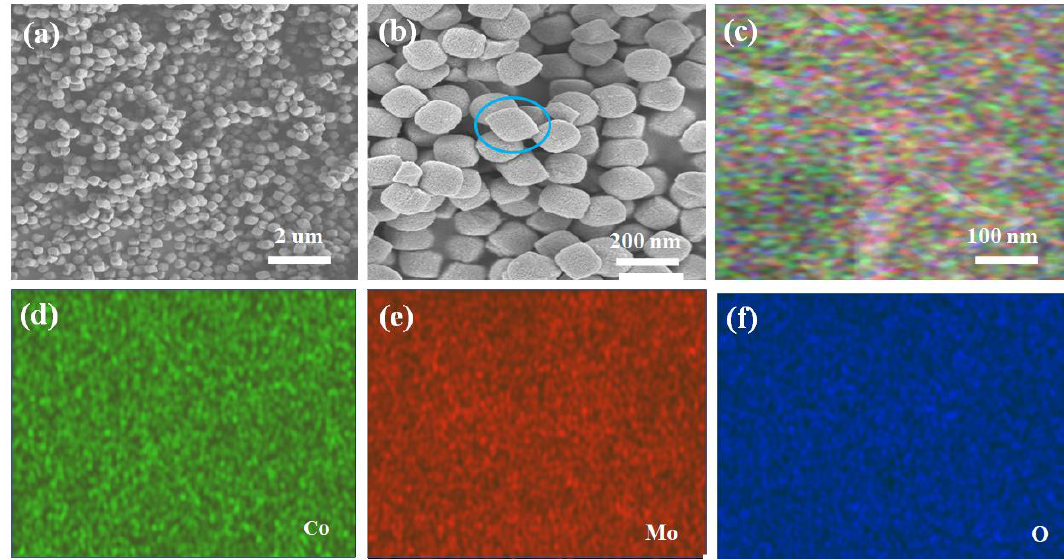
Figure 1. ( a , b ) SEM images of CoMoO 4 pie nanoparticles at different magnifications. ( c ) SEM mapping images of CoMoO 4 . ( d – f ) SEM mapping images of Co, MO, and O elements, respectively.